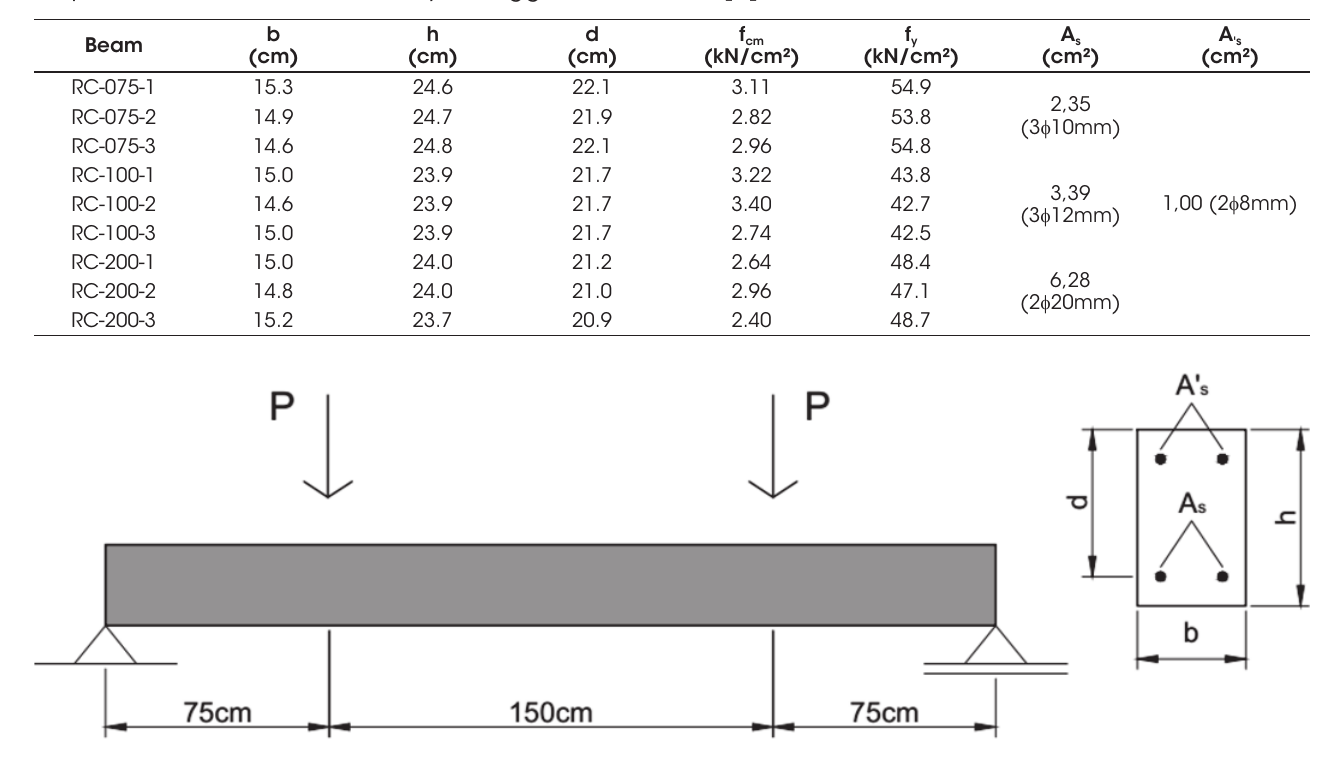
Properties of the beams tested by Schegg and Decanini [8]